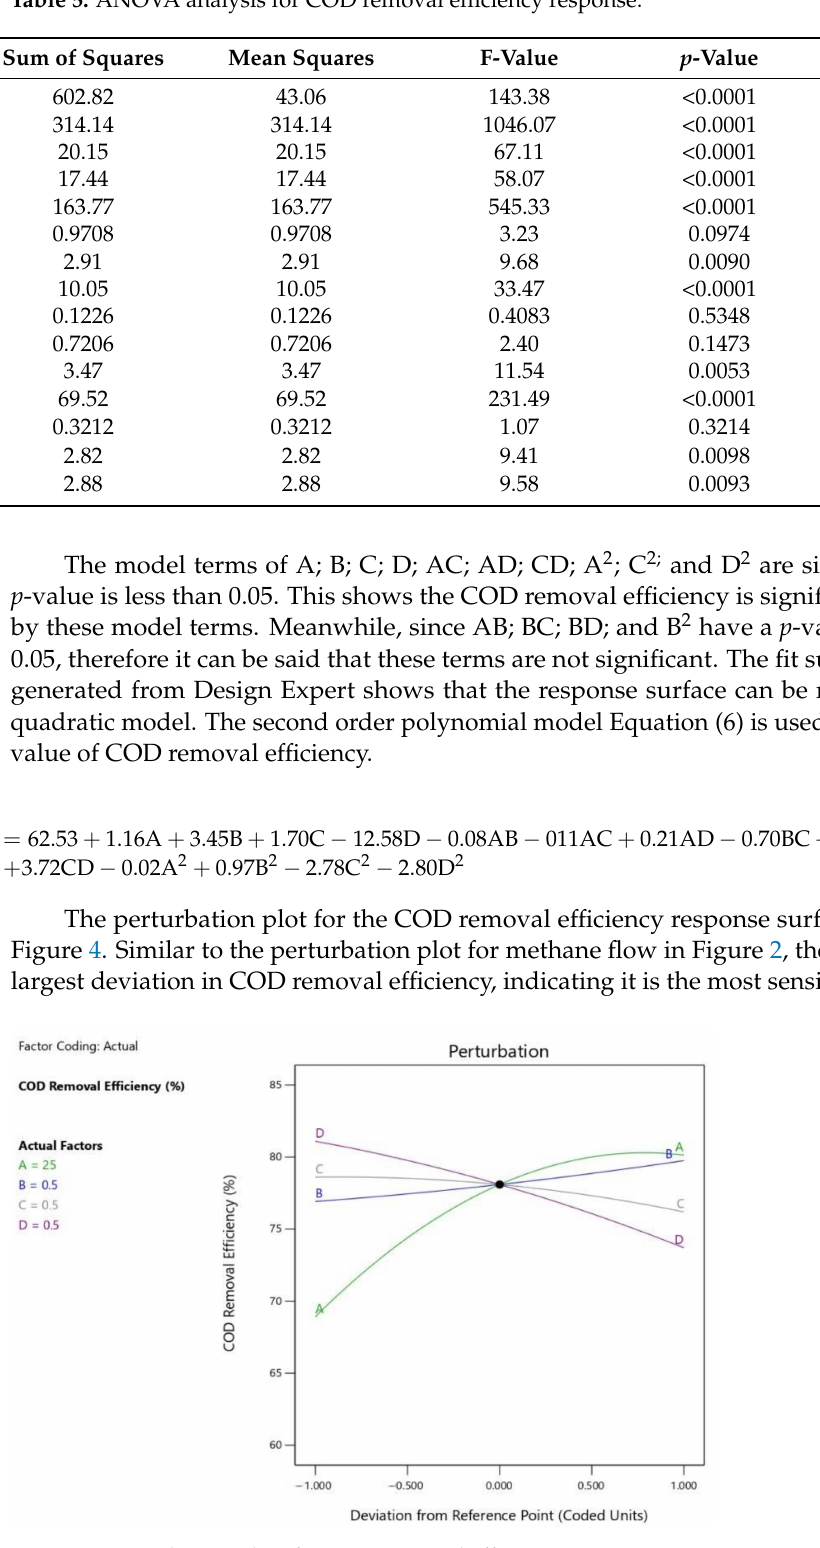
Figure 4. Perturbation plots for COD removal efficiency